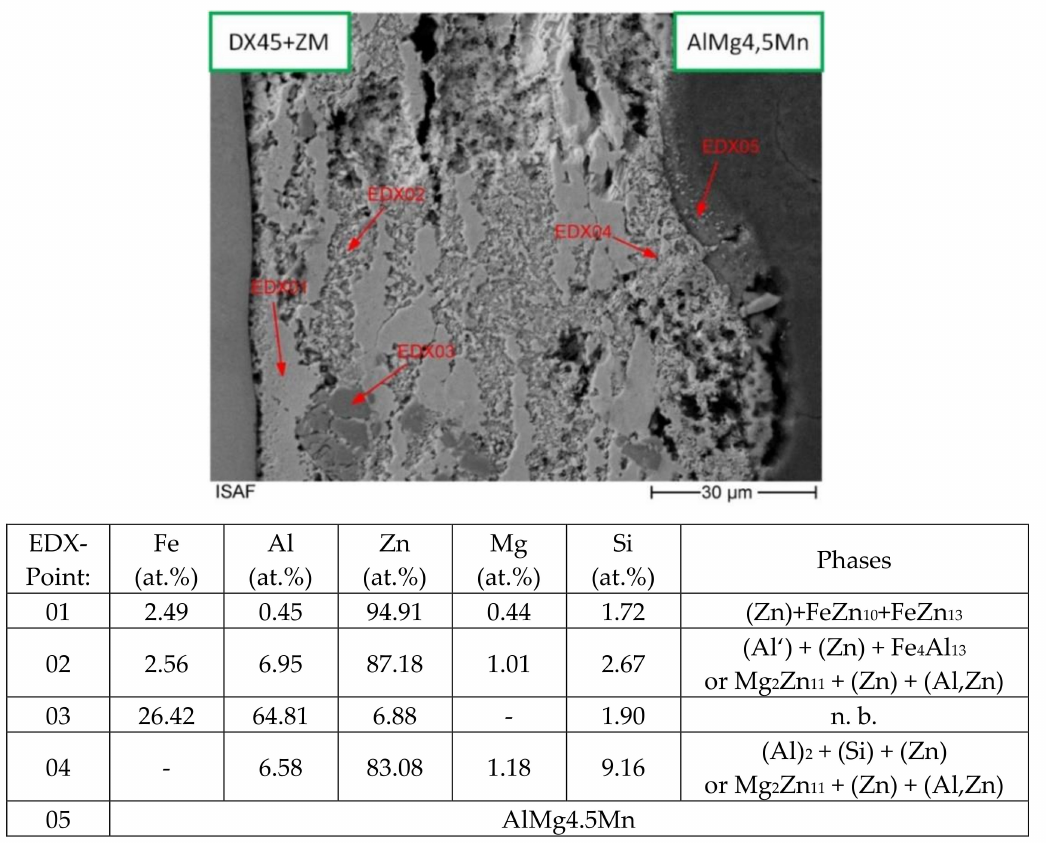
Figure 7. EDX analysis of the generated compound with magnesium in the zinc